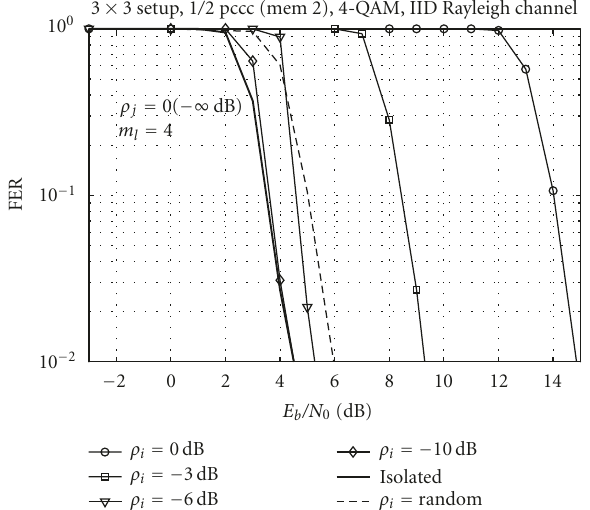
Figure 8: E ff ect of path loss of the dominant interferer ρ i , SAIC- DID. For the dashed curve labeled as “random”, each element of the path-loss vector 0 ≤ ρ l , m ≤ 1, l / = m , is randomly generated with uniform distribution.